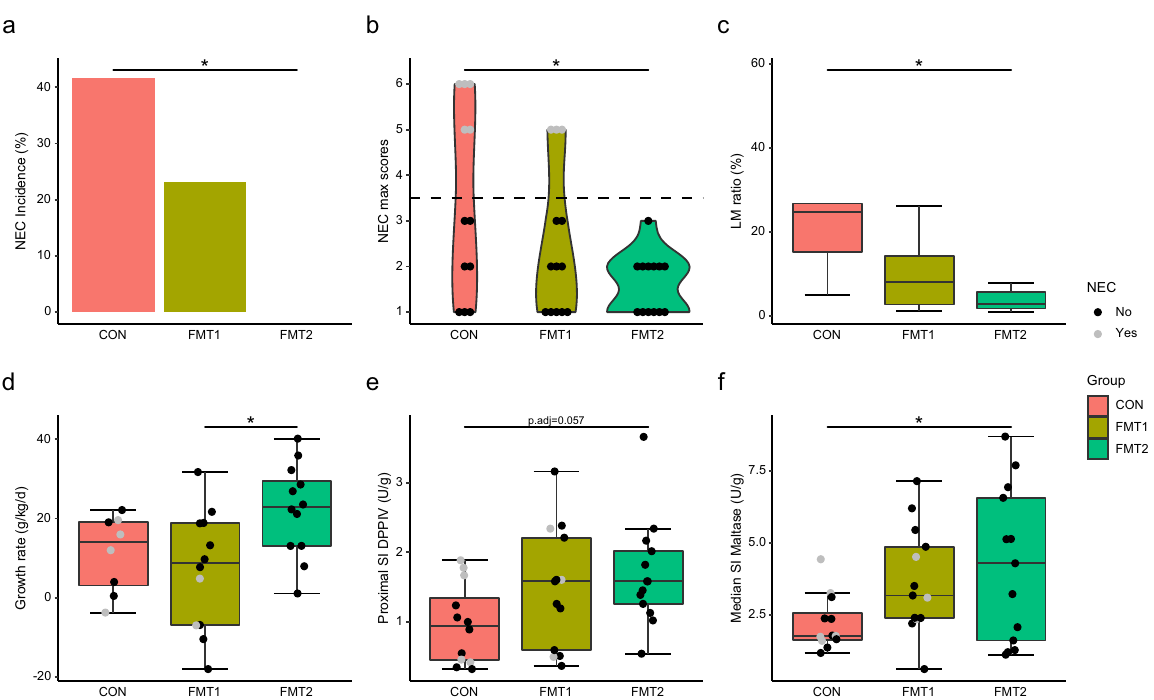
Fig. 2 Donor-dependent host response existed in recipient piglets. FMT2 piglets showed superior survival and development status with lower NEC incidence ( a ) and necrosis severity ( b ) and improved gut barrier ( c ), daily weight gain ( d ), and digestive enzyme excretion ( e , f ). The label of * represents adjusted p < 0.05. Except for NEC incidence (two-sided Fisher ’ s exact test), the statistical difference was determined by Tukey ’ s post hoc test. Except for LM ratio and growth rate, n = 13, 13, 12, respectively, for FMT1, FMT2, and CON. For LM ratios, respectively n = 8, 8, 5 while n = 12, 12, 8 for growth rate. In boxplots, the inner fences are depicted as error bars. FMT1 rectal FMT with Donor 1, FMT2 rectal FMT with Donor 2, CON rectal FMT with sterile saline as control, NEC necrotizing enterocolitis, LM ratio urinary lactulose-mannitol ratio, SI DPPIV dipeptidyl-peptidase IV activity in the small intestine, SI Maltase maltase activity in the small